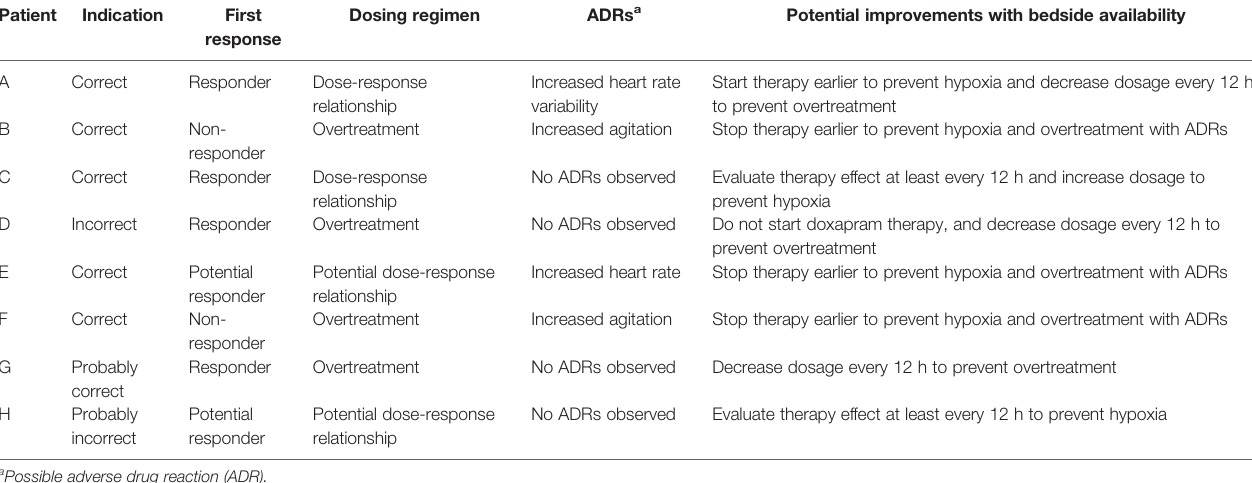
TABLE 2 | Overview of the retrospective evaluation and recommendations for improvements.